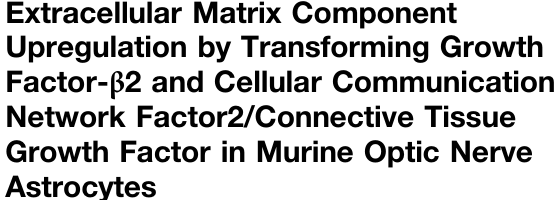
Frontiers in Cell and Developmental Biology |